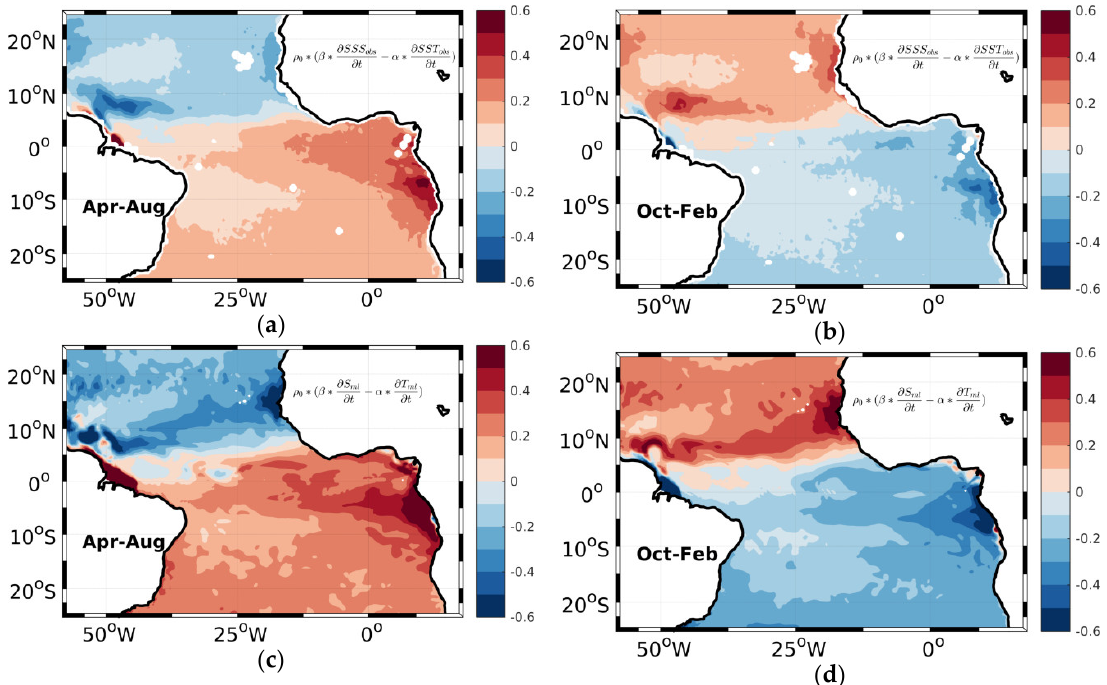
Figure 2. April-August ( a ) and October-February ( b ) average of surface density tendency from observations. The density is obtained with a linear density equation. ( c , d ) are the same as ( a , b ) for model data. Units are in kg.m −3 month −1 .